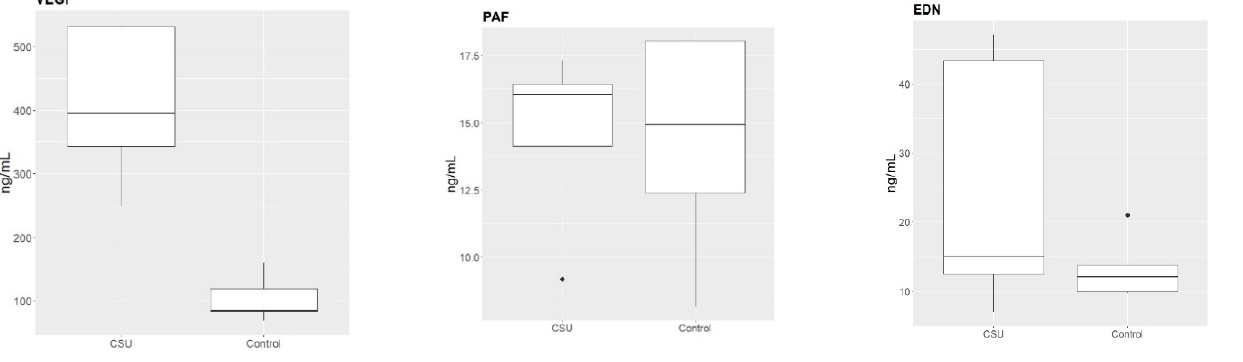
Figure 1. The mean serum concentrations of the examined molecules in patients with chronic spontaneous urticaria (CSU) and healthy control.